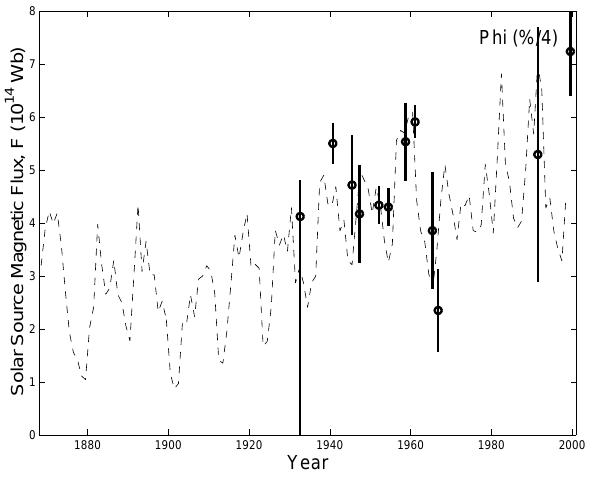
Fig. 4. The same as for Fig. 1 for 8 0 , the 8 values that have been corrected to account for the variation of (r + dr)/r for each eclipse using the simple geometric formula given in Eq. 5.